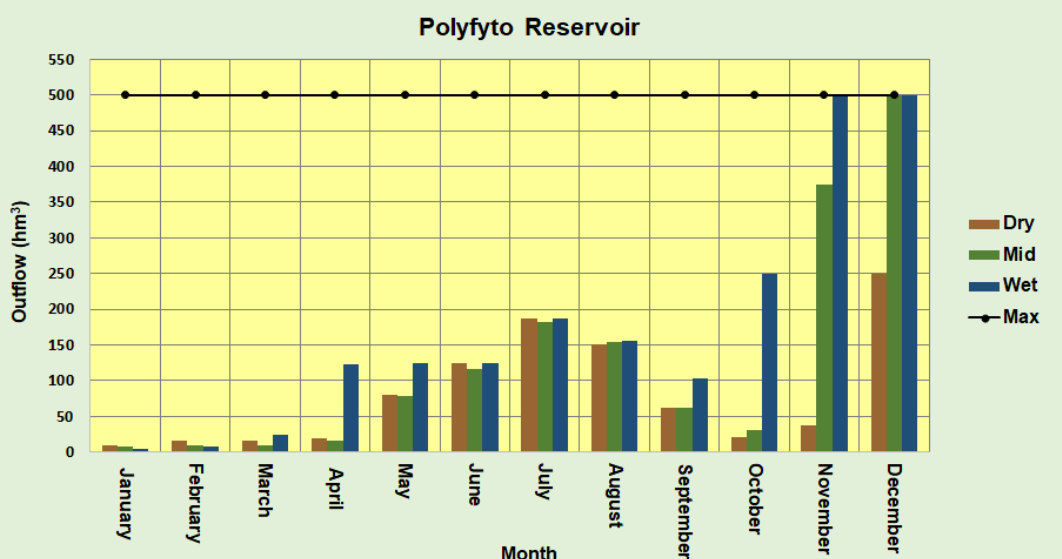
Figure 10. Monthly hydro energy production of the Aliakmon’s system, ignoring the institutional operating rule curves. 5.1.2. Optimization Applying the Institutional Operating Rule Curves Applying the curves of the institutional rules of operation of Ilarion and Polyfyto, the maximum production of hydroelectric energy achieved by GAs was 725.25 GWh, 1136.03 GWh and 1545.52 GWh, for the dry, mid and wet scenario, respectively. In dry hydrological conditions the total produced hydroelectric energy is lower by 2.8%, mainly due to the reduction of the production of the Ilarion hydropower plant. For mid and wet hydrological conditions, the production is 3.9% and 4.2% lower, respectively. The efficiency and operating policies of the system are affected, depending on the hydrological conditions of the river inflows. Ilarion’s operating policy tends to be completely identical with the institutional rule all the year. Polyfyto’s scheduling is identical to the institutional rule at the beginning and at the end of the year, while for the remaining months the water level is lower. The Ilarion reservoir from the beginning of January to the end of May, when it acquires the maximum volume, stores inflows to the extent allowed by the curve of the institutional rule of